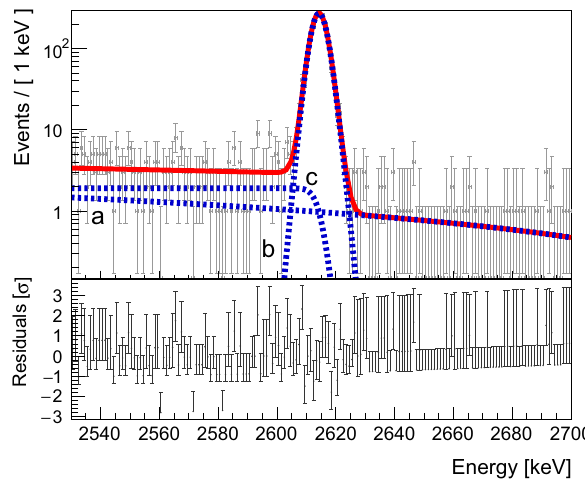
Fig. 10 Simultaneous fit of calibration data 2615 keV γ peak, and residuals for all channels in a single dataset with Poisson errors in each bin. Top: the summed total effective fit components (dashed blue lines) are labeled. Component (a) is the total excess background modeled by a linearfit,component(b)isthesumofGaussianlineshapesusedforeach channel, and component (c) is the smeared step function to represent multi-Compton background. The simultaneous fit is shown as a solid line.Bottom:theresidualsofthefitshowingoverallexcellentagreement across the model with the central core well